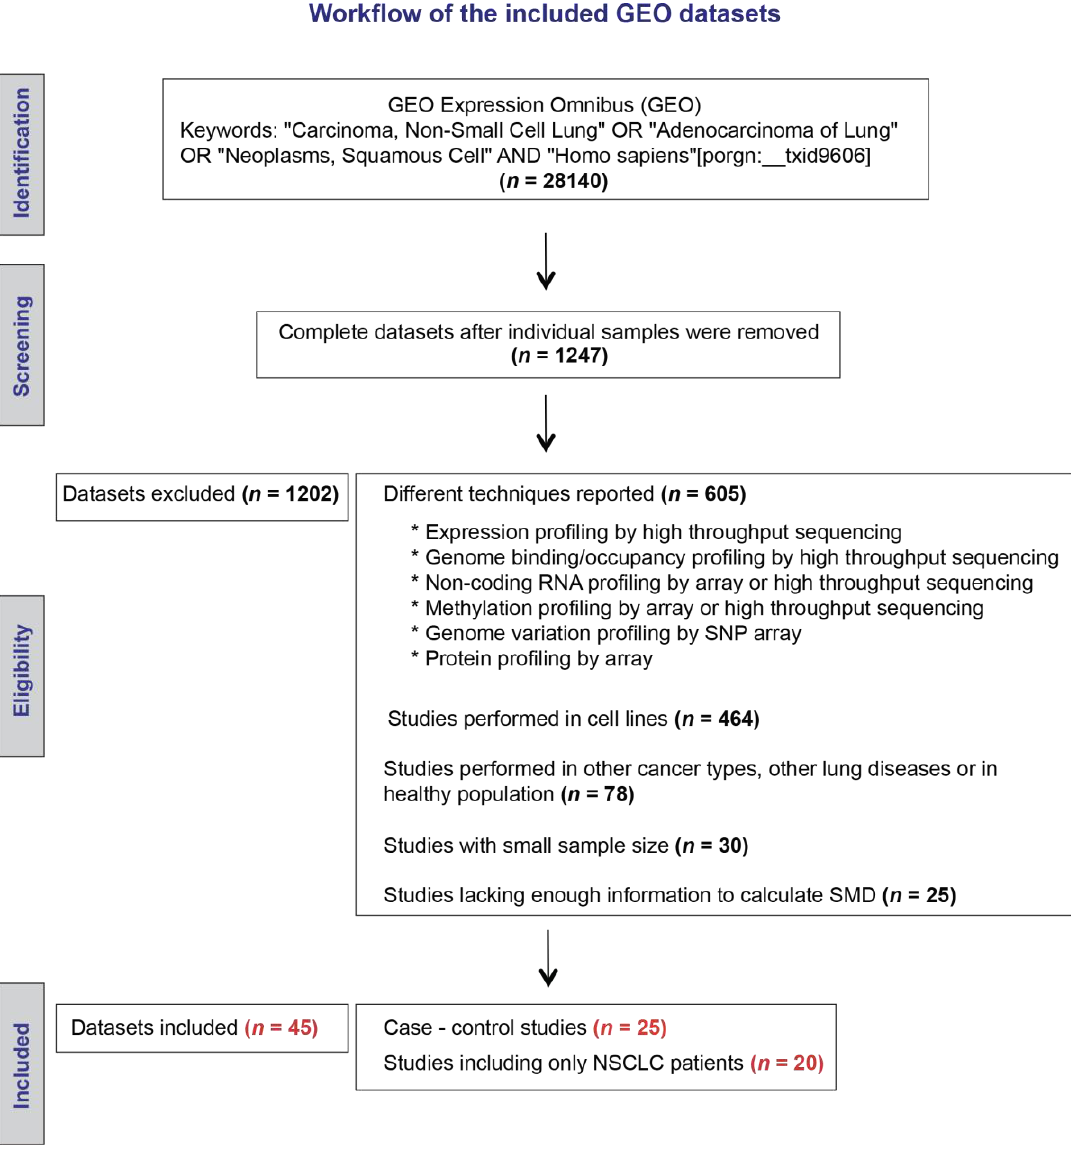
Figure 1. Workflow of the included Gene Expression Omnibus (GEO) datasets.